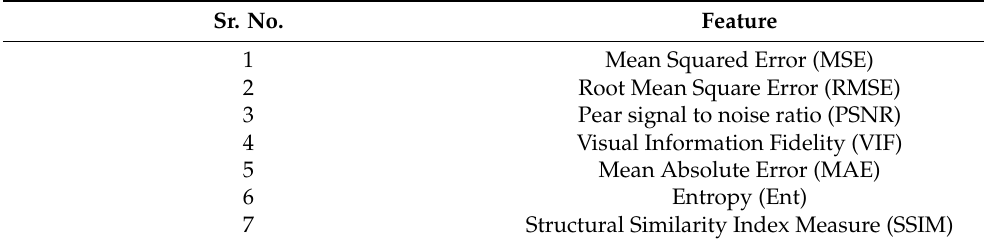
Table 2. Features extracted from the images. Sr.